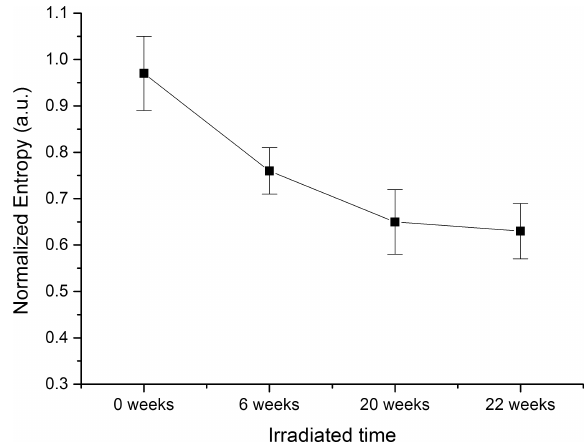
Fig. 5. The entropy of skin at di®erent time points.